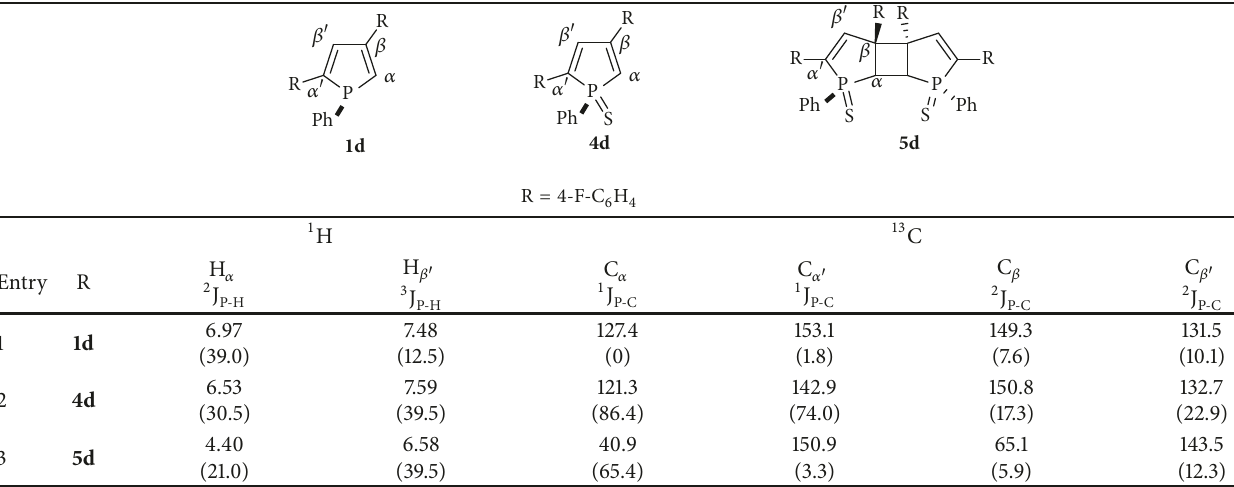
Table 4: Chemical shifts (ppm) and coupling constants (Hz) of 1d , 4d, and 5d .